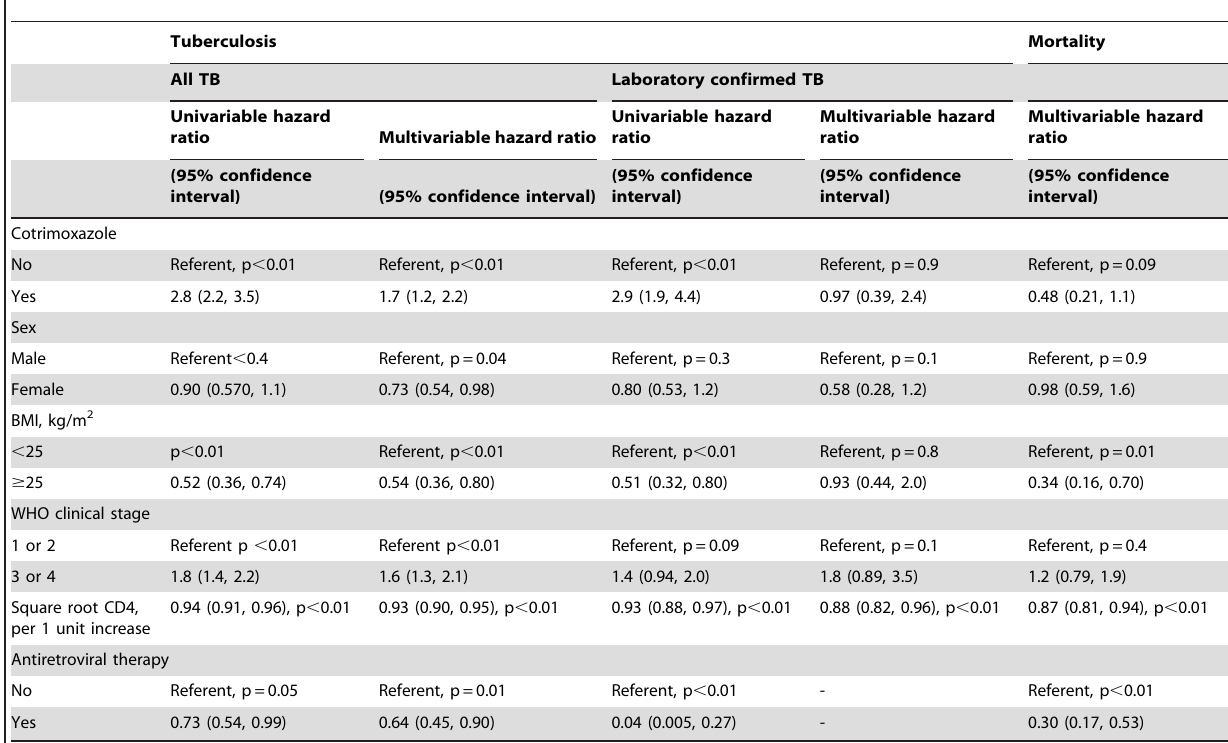
Table 2. Characteristics associated with all TB, laboratory confirmed TB, and